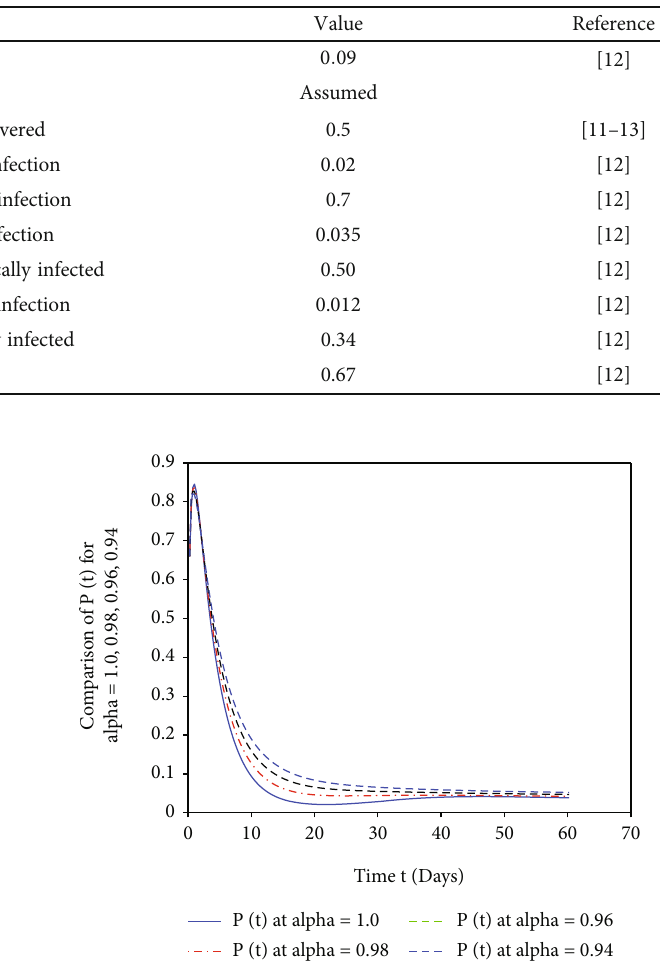
Figure 7: The chronically infected P ð t Þ for ϱ = 1 : 0, 0 : 98, 0 : 96, 0 : 94 .